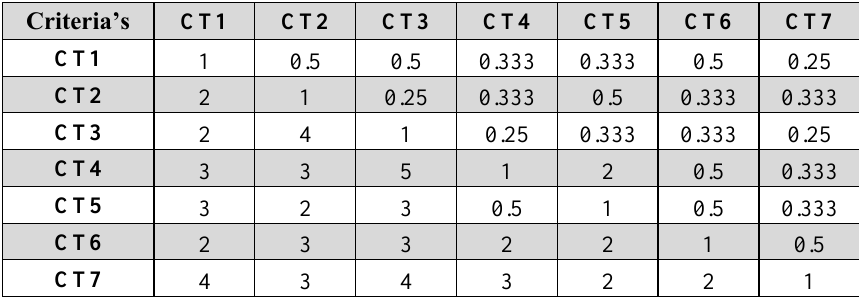
Table 2. Comparison of pair-wise